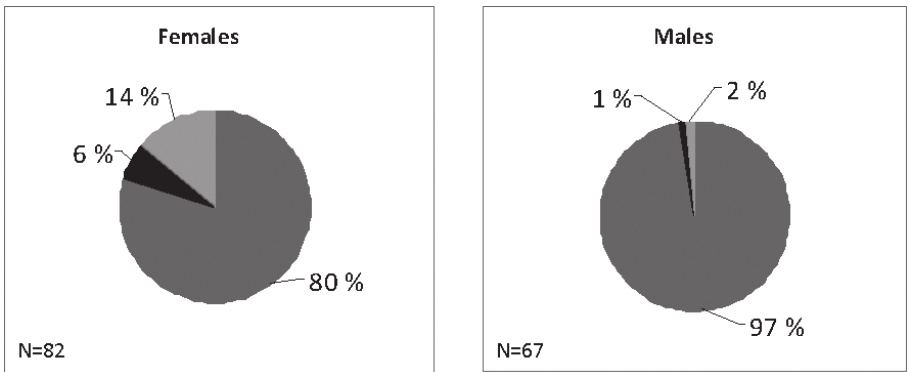
Figure 5. Comparison of the autumnal diet between female and male sub-samples of T. andreinii . Grey: green vegetables; light grey: fibres; black: arthropod